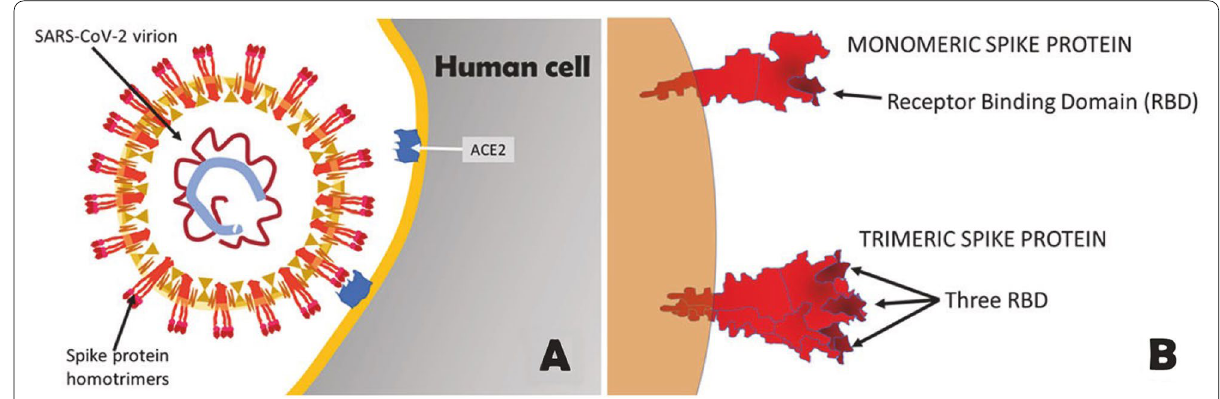
Fig. 1 Schematic representation of SARS-CoV-2 and Spike glycoprotein